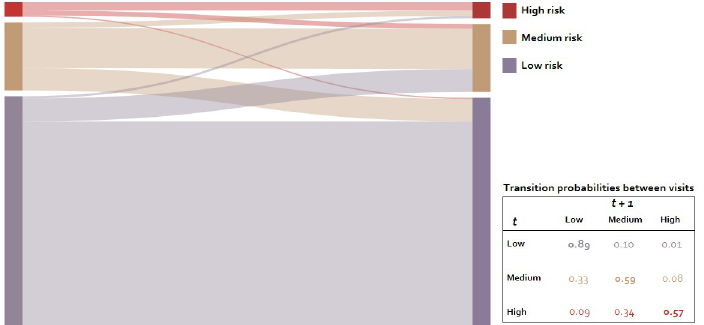
Fig 1. Six-month transition probabilities between visits classified as low (73%), medium (22%), and high risk (5%) among MSM participating in the Amsterdam Cohort Studies, Amsterdam the Netherlands, between 2008 and 2017 (n = 7,865). Thickness of the lines represent the group size relative to the rest of the population.